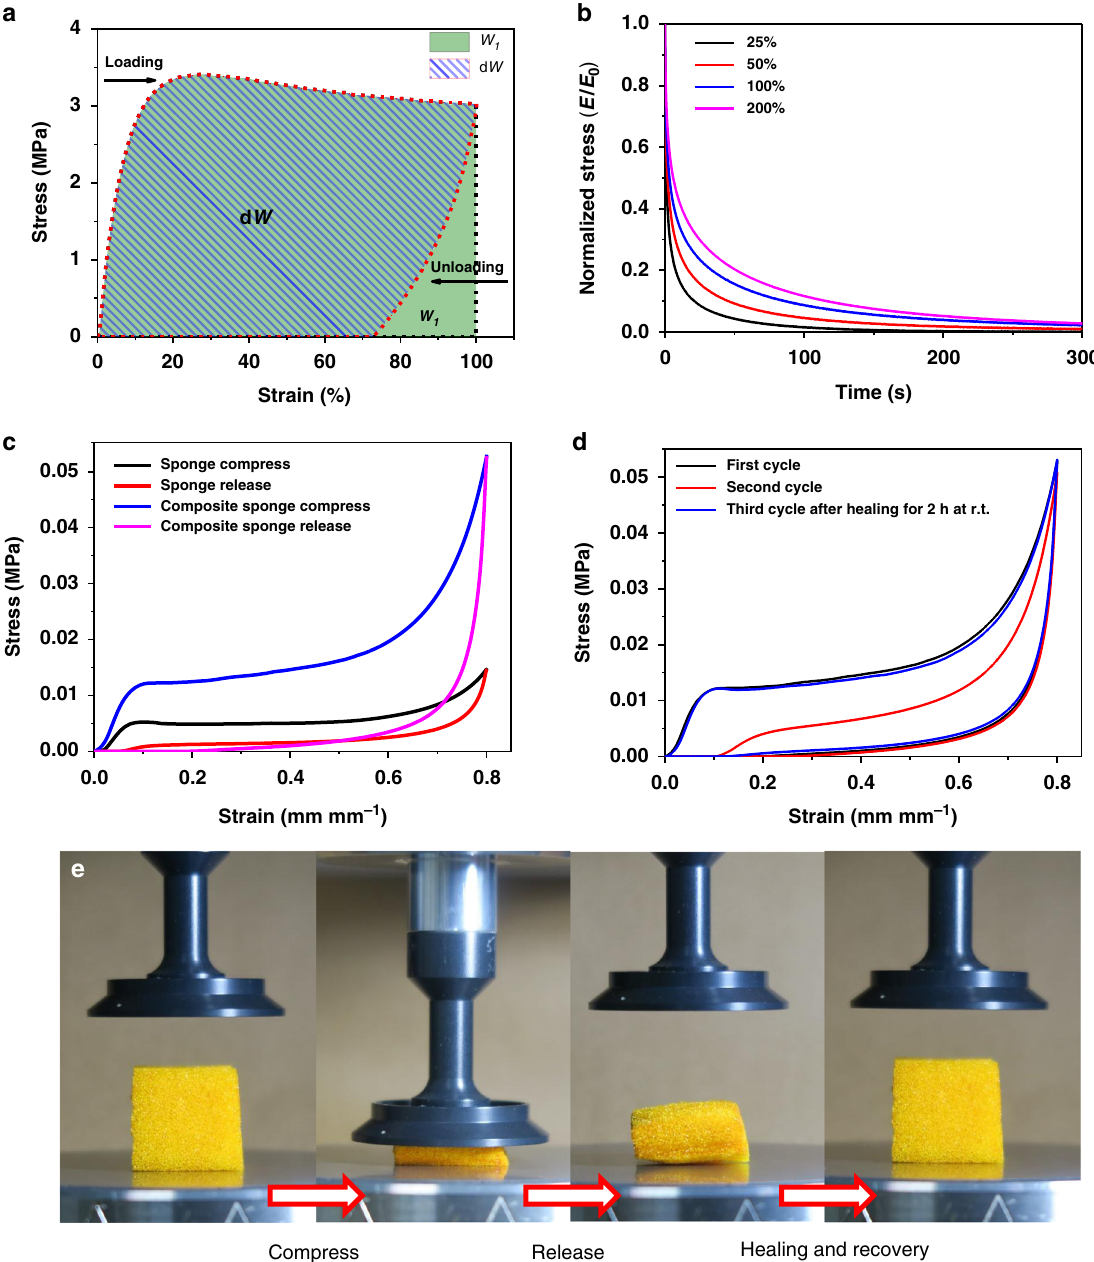
Fig. 4 The energy absorbing properties of Zn(Hbimcp) 2 -PDMS polymer. a The calculation of energy absorbing ef fi ciency. b Normalized stress – relaxation curves under different strain. c Cyclic strain – stress curves of blank sponge and composite sponge. d Cyclic strain – stress curves of composite sponge with healing process. e Optical images of the composite sponge under compression, healing, and recovery